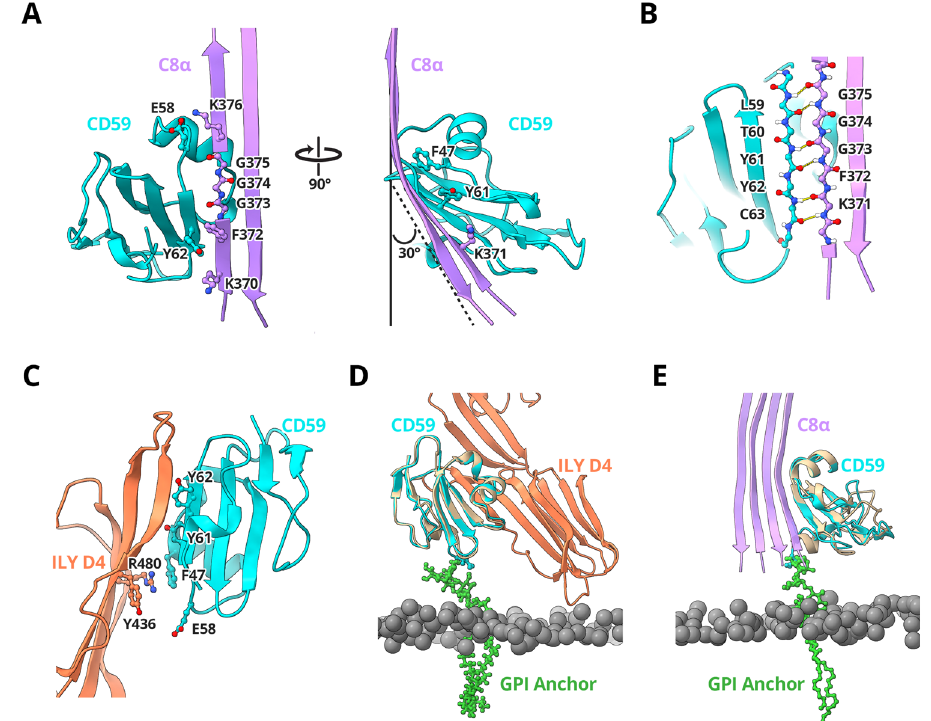
Fig.3|CD59interactioninterfaces.A RibbondiagramoftheC8 α -CD59interface. CD59(cyan)capturestheextendingTMH2residuesofC8 α